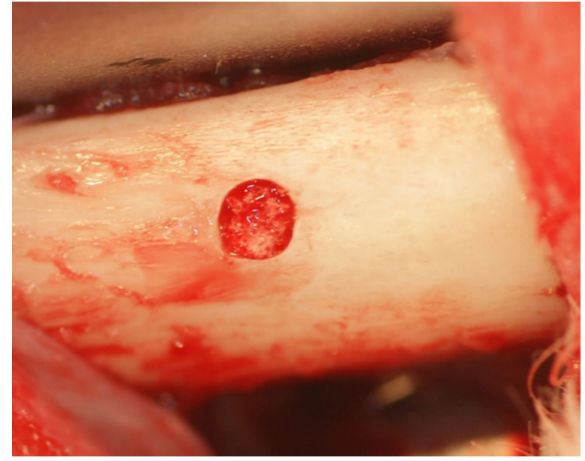
Figure 4. Sample placed into the bone socket of the rabbit femur.